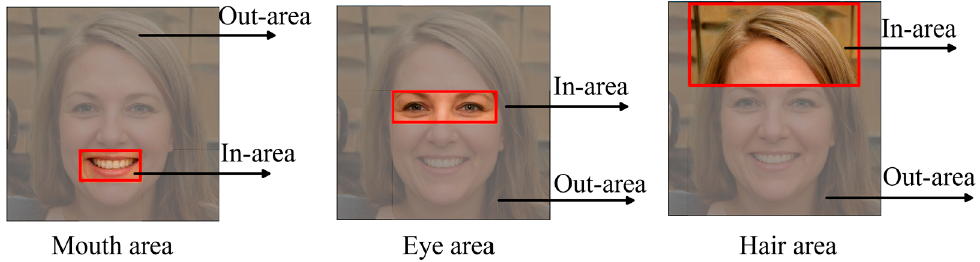
Figure 7. Semantic attribute local and non-local area examples of face mouth, eye, and hair areas.